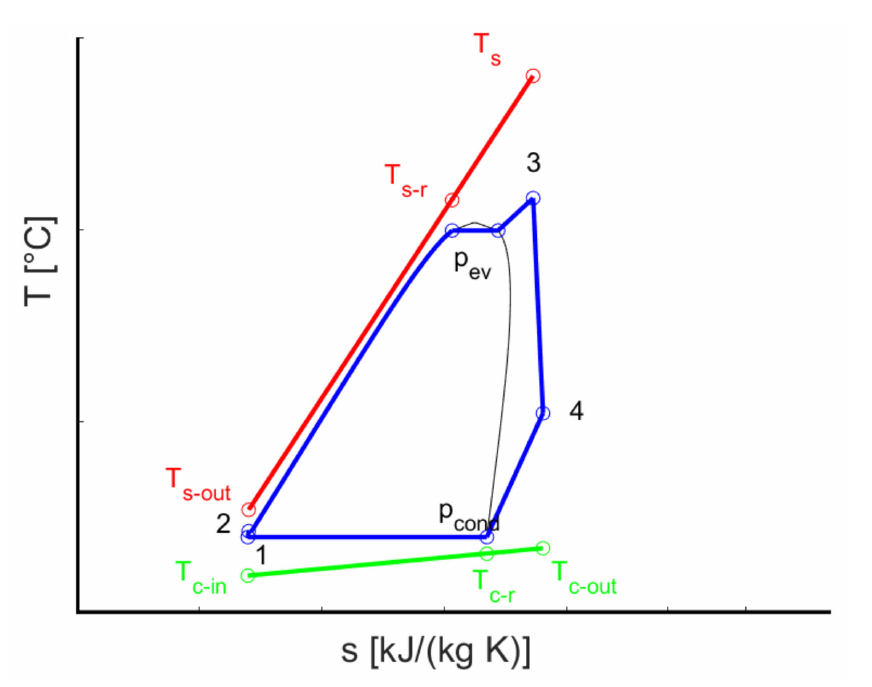
Figure 2. ORC cycle in a T-s